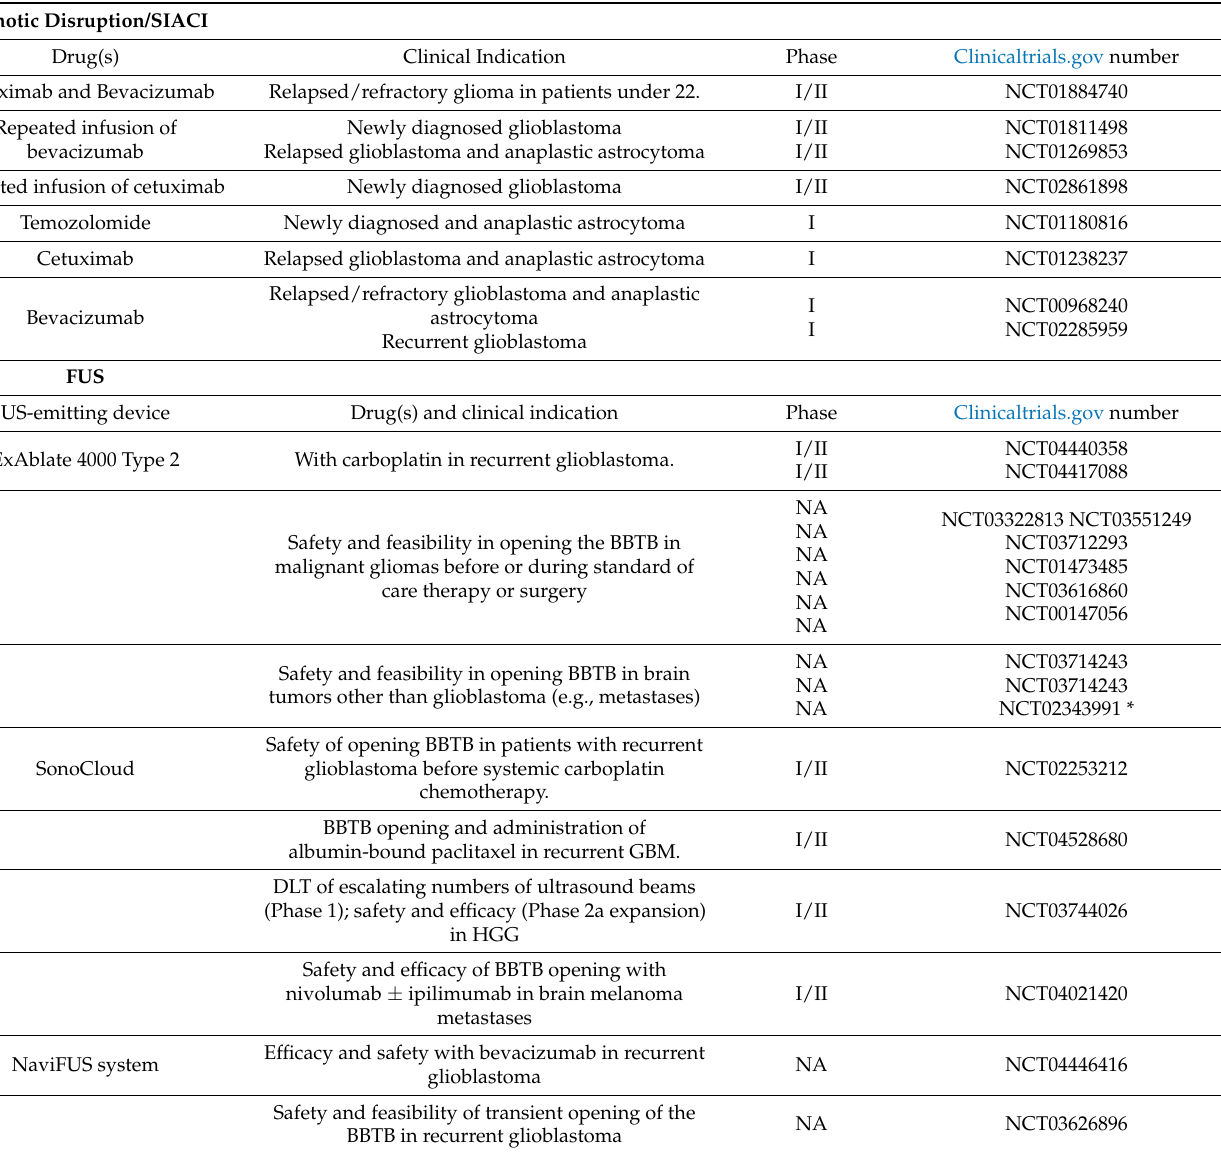
Table 2. Clinical trials based on increasing the permeability of the BBTB